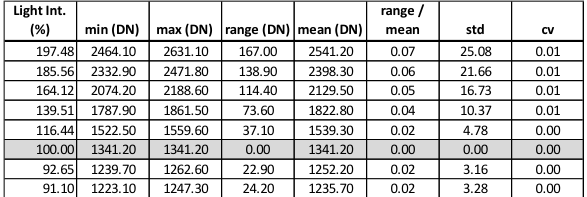
Table 1. Descriptive statistics of the LUT applied to different light intensities shown in percent of the calibration intensity (in gray).